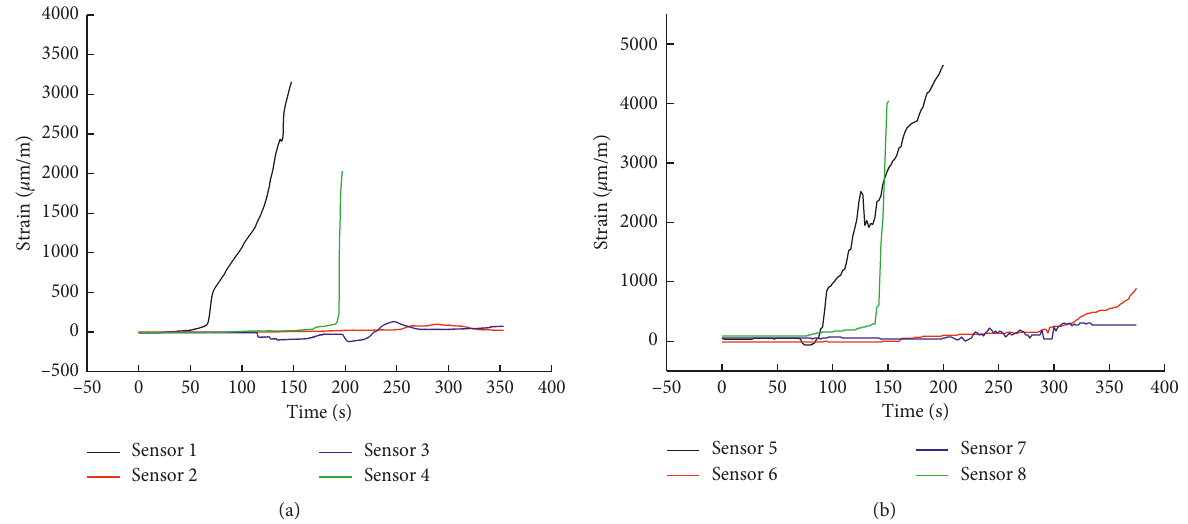
Figure 6: The grating strain-time curve at 30mm from the roadway wall: (a) the strain-time curve of 1–4 FBG sensors and (b) the strain- time curve of 1–4 FBG sensors.